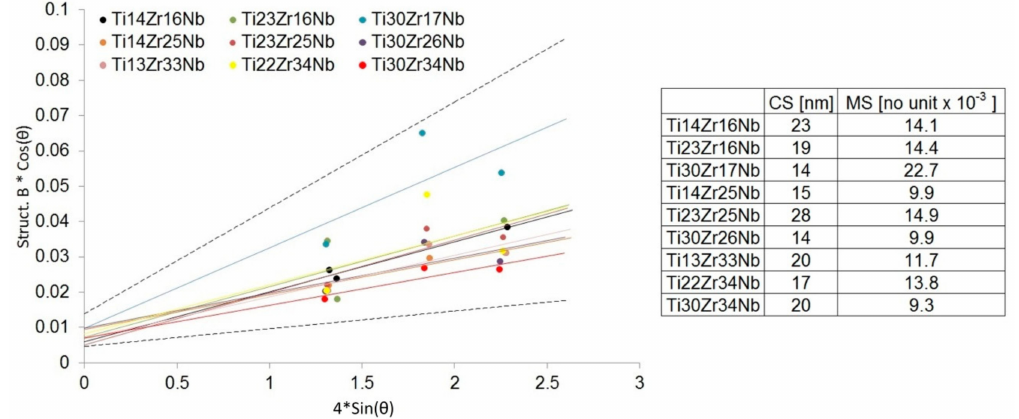
Figure 3. Linear Williamson–Hall plots with estimated crystallite size (CS) and microstrain (MS)